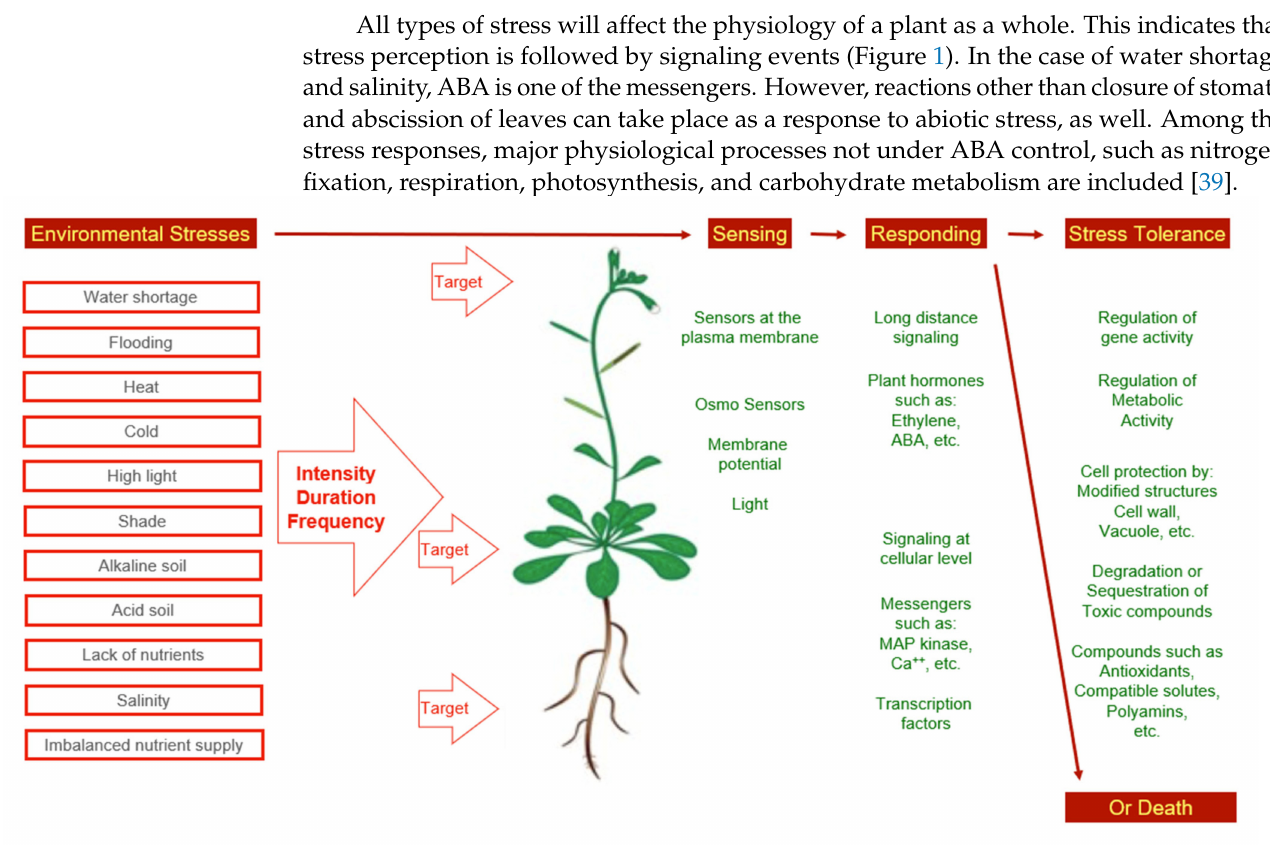
Figure 1. Environmental stress and observed concepts of stress